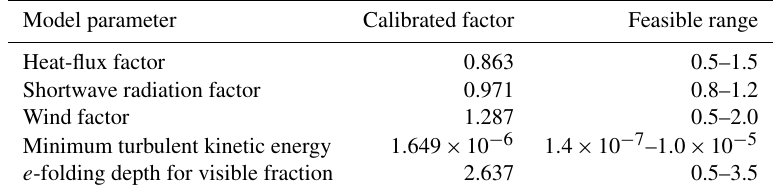
Table 2. Best parameter set from ACPy over the entire calibration period (April–November) between 1961 and 2017.